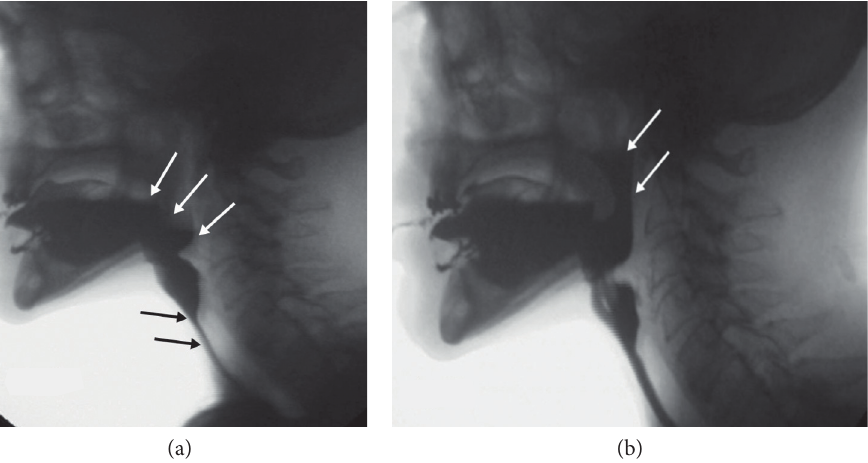
Figure 2: Lateral fl uoroscopic view of a 74-year-old man who has undergone a previous laryngectomy and subsequent resection of the left posterior tongue and left tonsillar region. The patient has poor oral bolus control and early loss into the neopharynx ((a), white arrows). Black arrows show a narrowing in the neopharynx with dysfunction of reconstructed cricopharyngeal junction and residue throughout the neopharynx. (b) Palatopharyngeal valve dysfunction and re fl ux of contrast (white arrows) between the soft palate and the posterior pharyngeal wall.